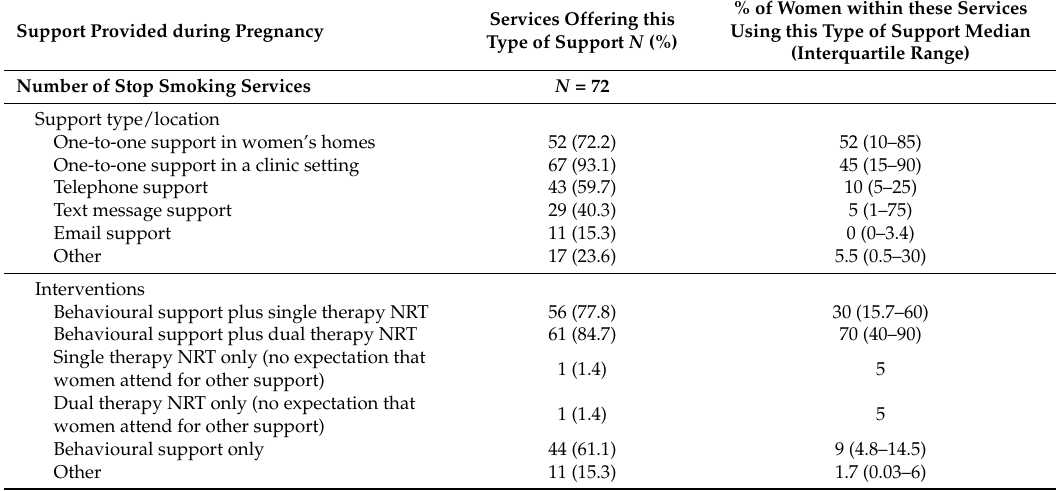
Table 1. Types of support offered by Stop Smoking Services (SSS) during pregnancy, and support suggested for preventing return to smoking